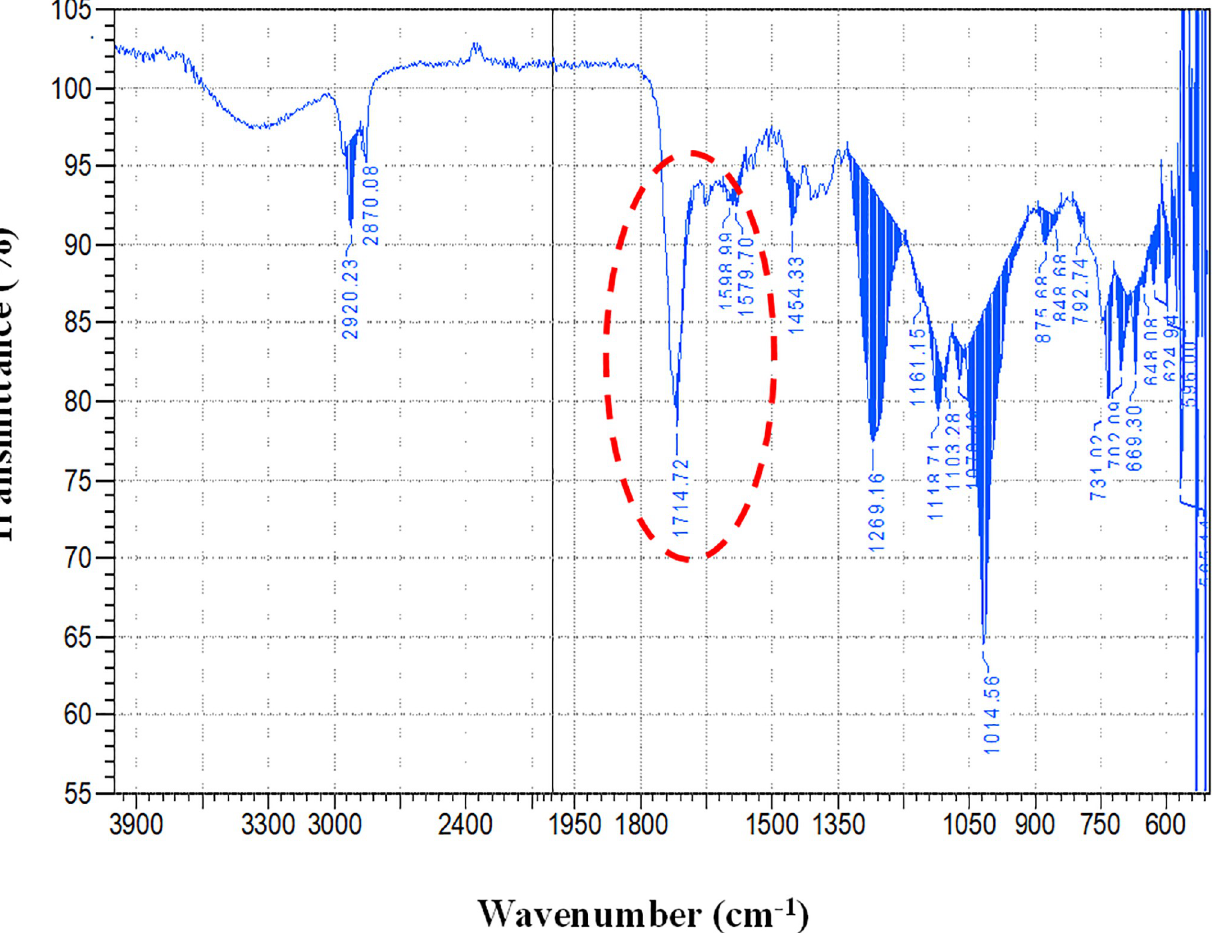
Fig 4. FTIR analysis of the f-MWCNTs modified GFRPs composite containing 0.4 wt. % f-MWCNTs